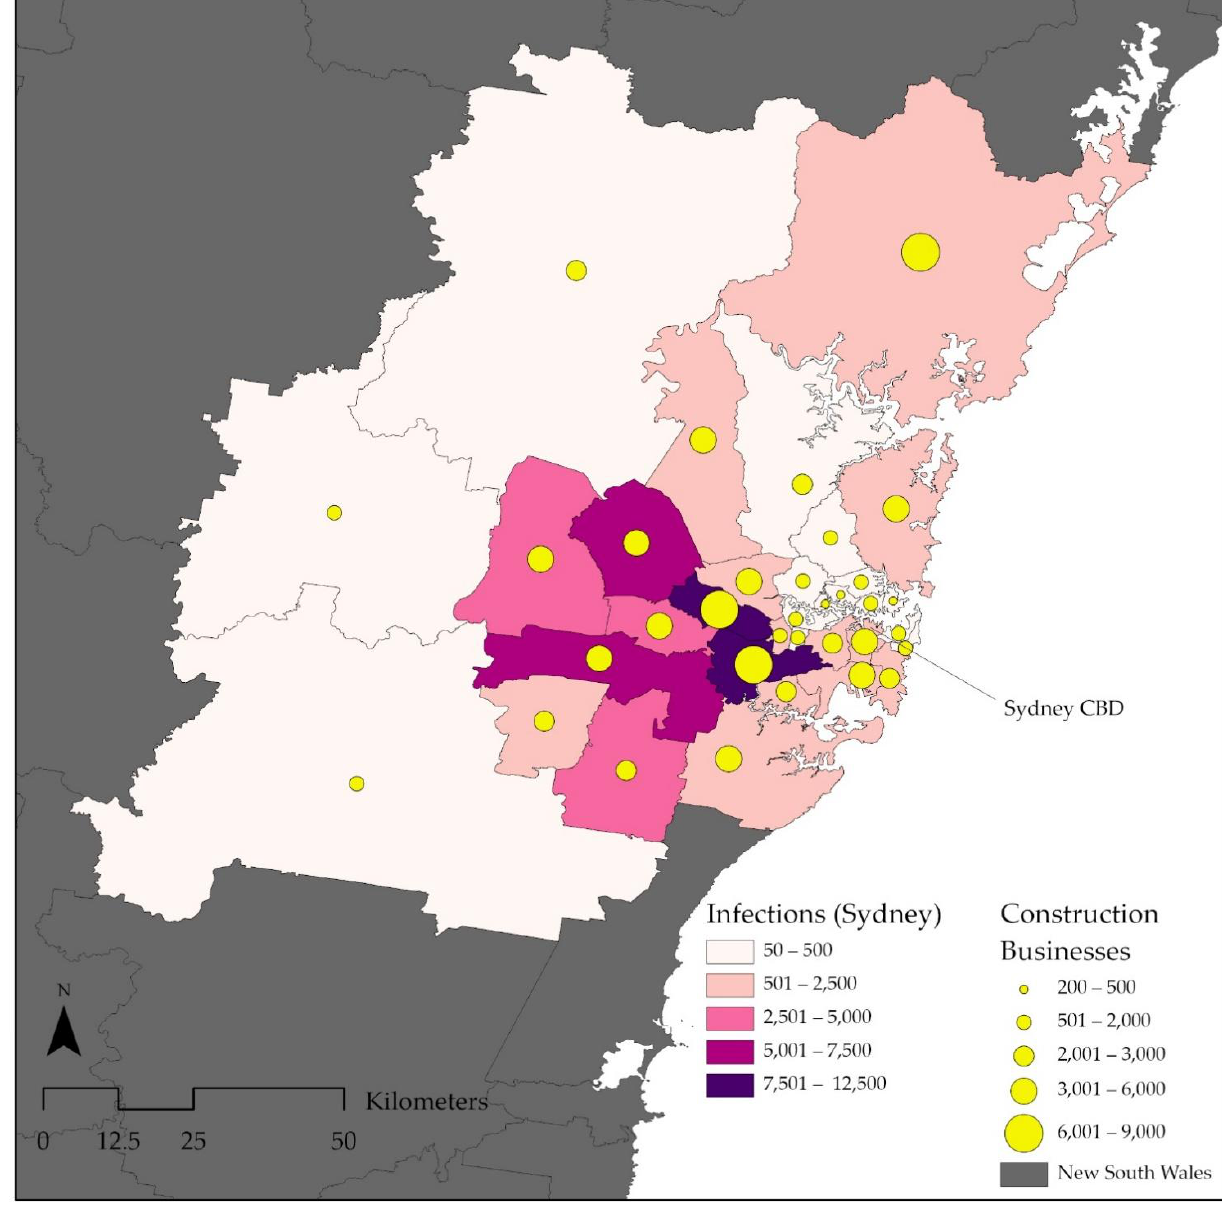
Figure 7. Choropleth map showing COVID-19 cases overlayed by graded symbology showing con- construction business counts across struction business counts across Sydney.